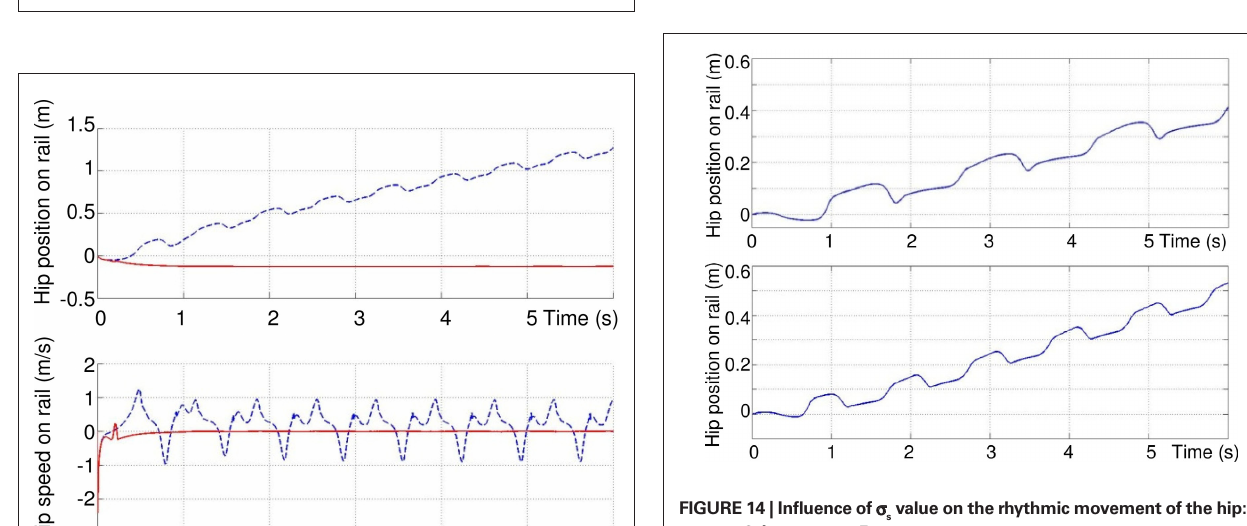
FiguRe 12 | Statistical analysis: 247 different initial conditions of the leg for eight values of σ . Red bars: percentage of trials the model with s the contact feedback slides ahead on the rail; leg is not blocked due to initial conditions. Blue bars: mean value of improvement in presence of GCS (final position with GCS/final position without GCS).